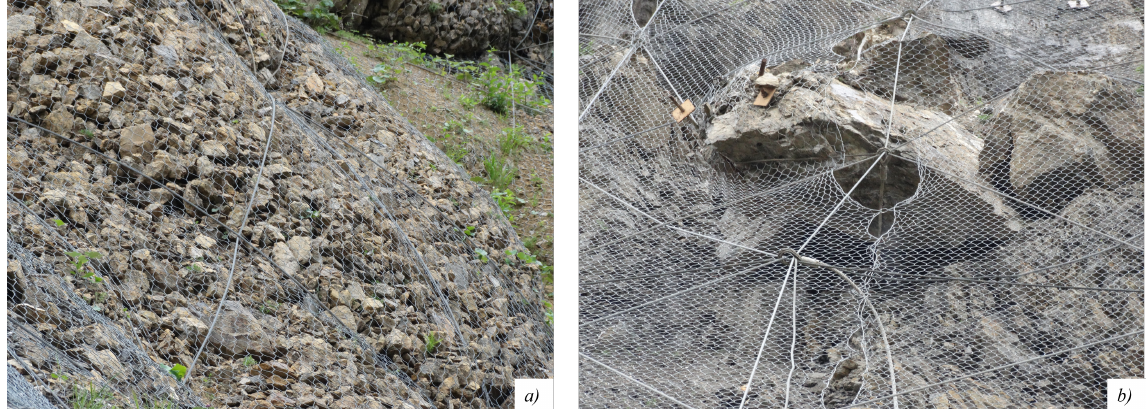
Figure 5. Retaining effects of ropes ( a ) and failure if too slack ( b